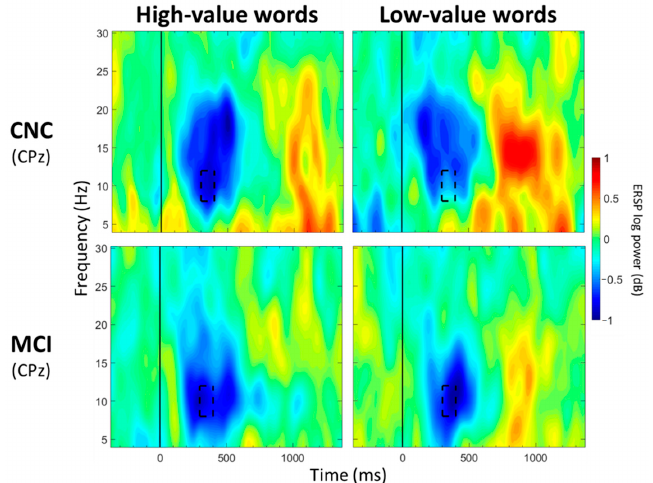
Figure 6. ERSP Comparisons for Alpha Band for Interaction Effects Between Group and Value. Spectrograms illustrate differences between groups (CNC/MCI) and value (high-/low-value) for alpha band (8–12 Hz) at CPz. The 0 ms time point (solid vertical line) represents stimulus onset. Dashed black rectangles indicate the time windows in which significant interaction effects between group and value were observed (also see Table 5). CNC: Cognitively normal older controls; MCI: mild cognitive